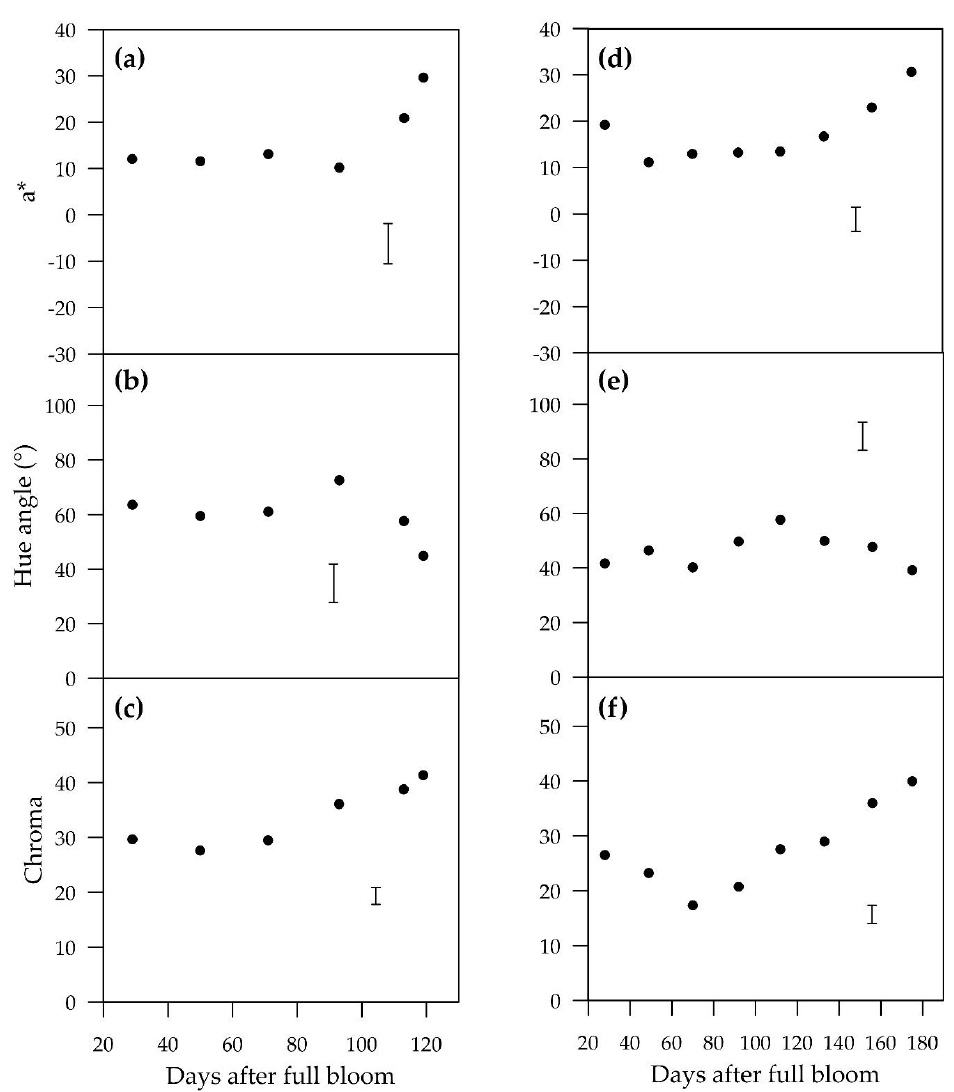
Figure 1. Temporal change in means of a*, hue angle and chroma of control treatments (no shading) of “ANP-0118” ( a – c ) and “ANP-0131” ( d – f ). Error bar represents Fisher’s LSD at 5% level of significance.